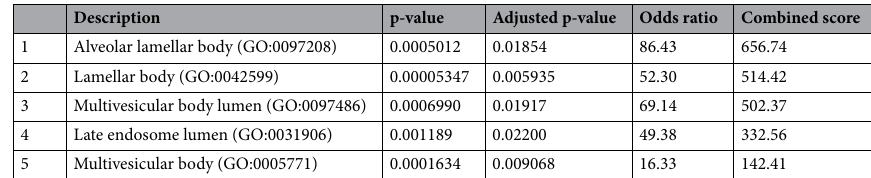
Table 3. Gene ontology cellular component-based enrichment analysis of down-regulated DEGs.